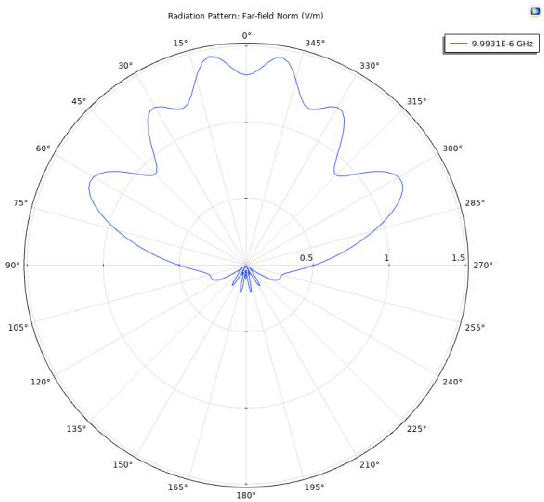
Figure 18. Two-dimensional far-field pattern for the H-plane.